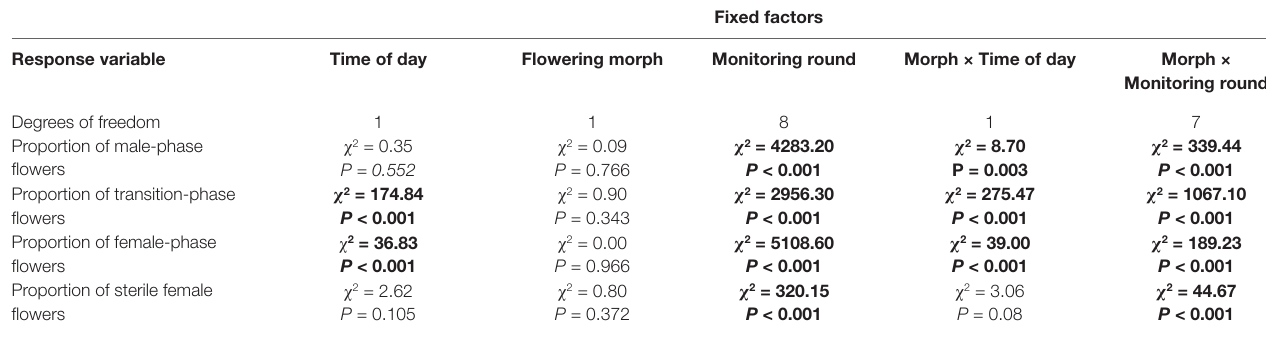
TABLE 1 | Summary of generalized linear mixed models, testing for factors influencing the proportions of male, transition, female, and sterile female flowers. The effects of the main factors in the models are reported, as well as the two-way interactions that involved flowering morph. Statistically significant effects (p < 0.05) are indicated in bold. Five Early trees and six Late trees were